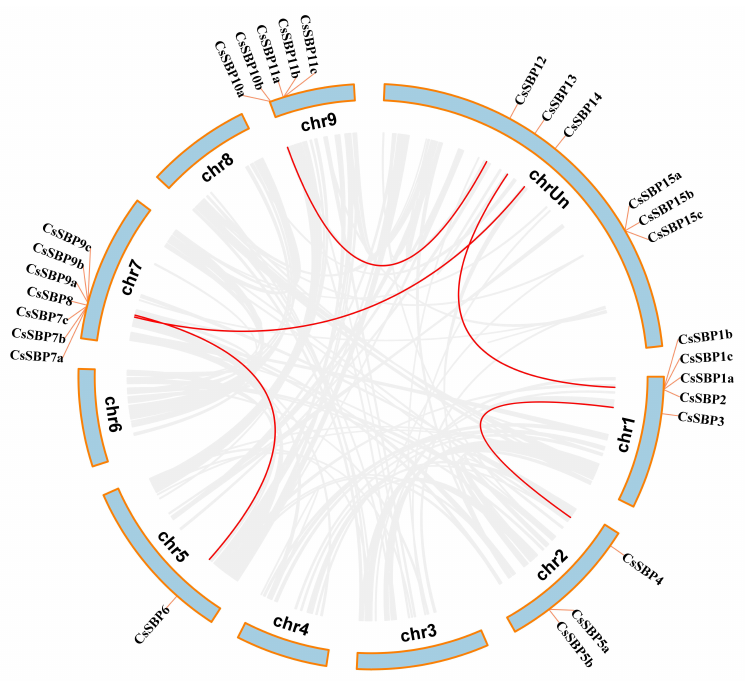
Figure 3. Duplication events of CsSBP genes. Circle plot showing duplication events of CsSBP genes on C. sinensis chromosomes. Red lines indicate duplication of CsSBP genes.